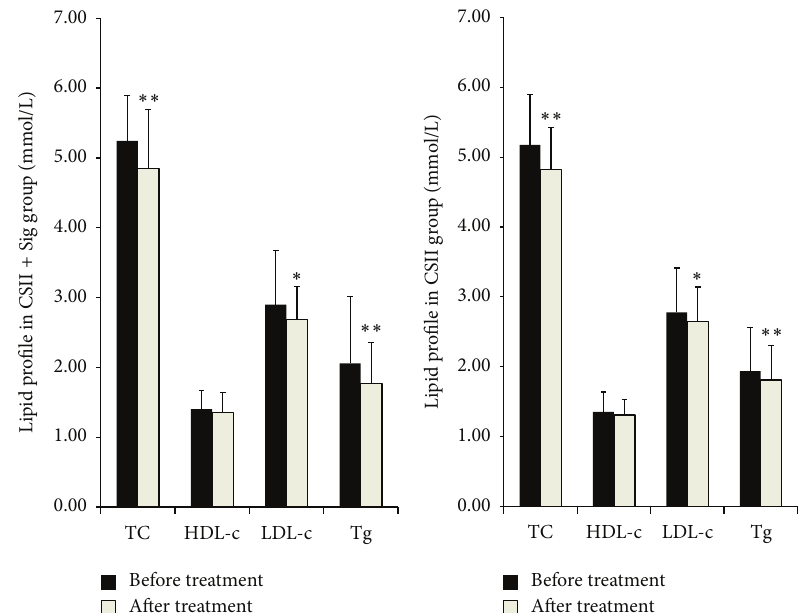
Figure1:Changesinlipidprofilebeforeandaftertreatmentforbothgroups.Note: ∗ 𝑃 < 0.05 and ∗∗ 𝑃 < 0.01 ;paired 𝑡 -tests(afterversusbefore treatment) were conducted. TC: total cholesterol; HDL-c: high-density lipoprotein-cholesterol; LDL-c: low-density lipoprotein-cholesterol; Tg: